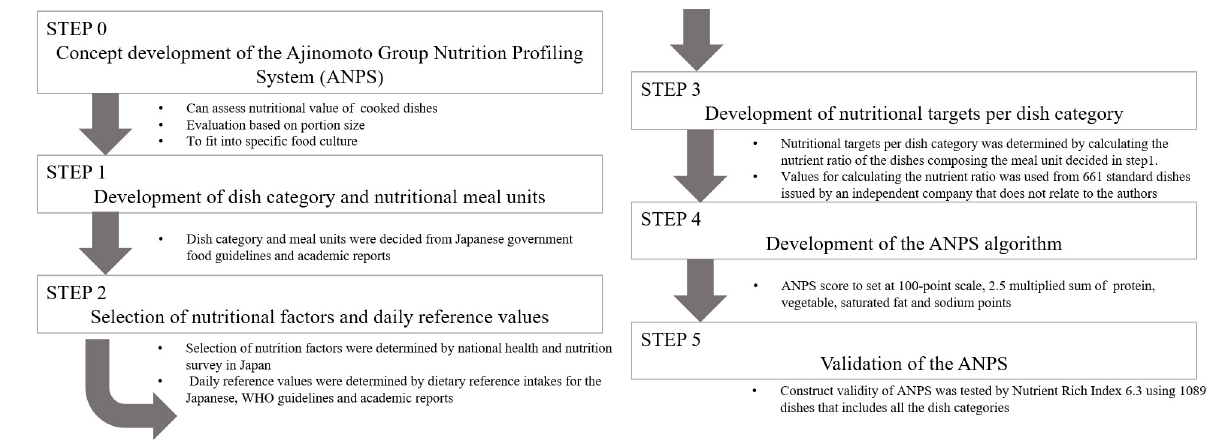
Frontiers in Nutrition |